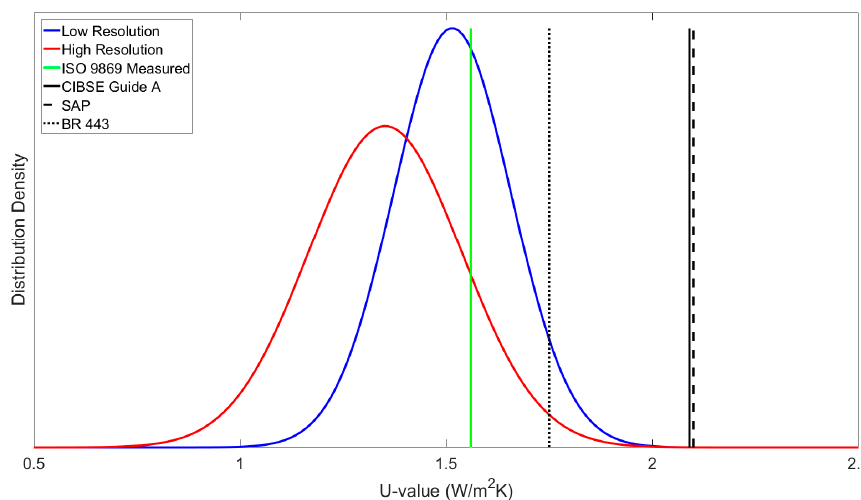
Figure 8. Normal distribution density of U-values from IRT for the master bedroom external wall, compared to a point measurement and standardised values.